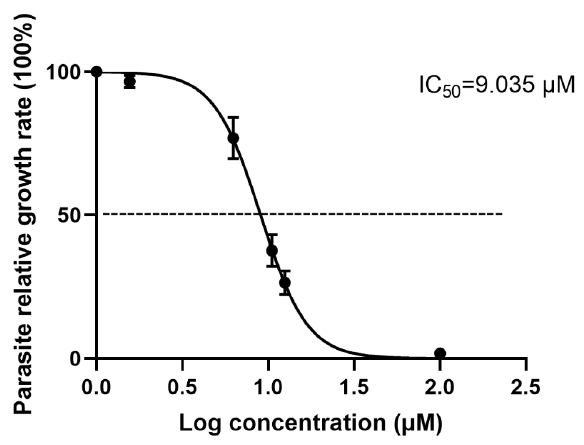
Figure 3. The 50% inhibition concentrations (IC 50 ) of artemether. RH-RFP was cultured in monolayers of HFF cells and treated with different concen- trations of artemether for 24 h. The growth rate of RH-RFP tachyzoites was statistically